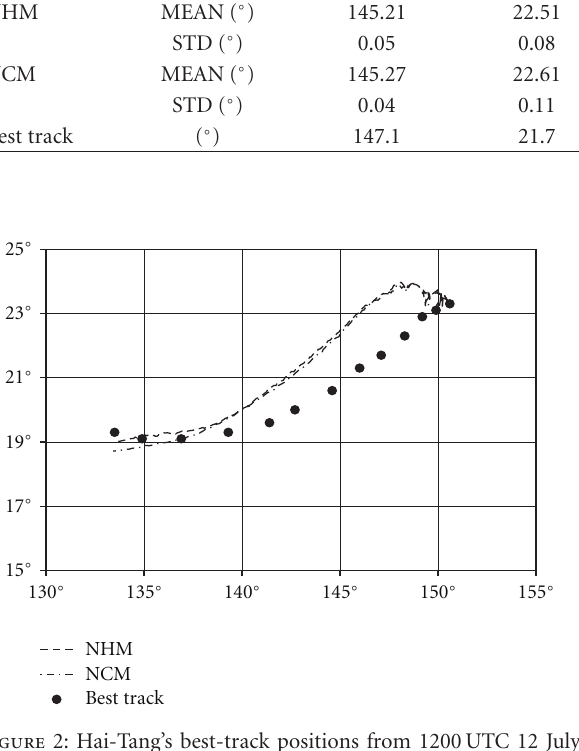
Figure 2: Hai-Tang’s best-track positions from 1200UTC 12 July (23 . 3 ◦ N, 150 . 6 ◦ E) to 1200 UTC 15 July 2005 (19 . 3 ◦ N, 133 . 5 ◦ E) and the mean predicted positions of the nine NHM and nine NCM experiments. Longitude is shown on the horizontal axis and latitude on the vertical